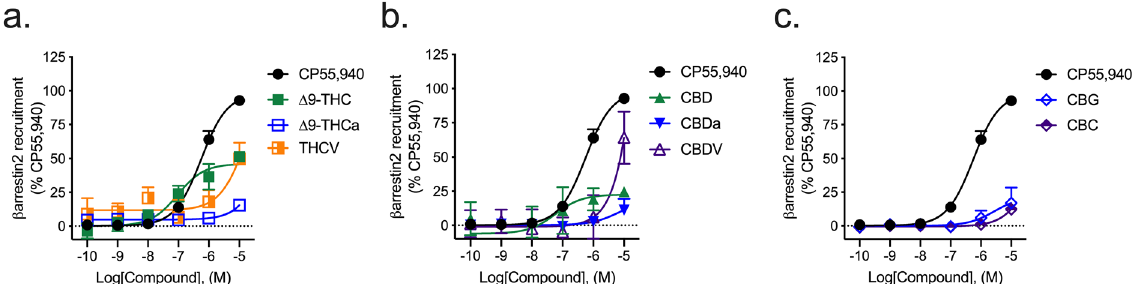
Figure 7. hCB2R-dependent recruitment of βarrestin2. hCB2R-dependent recruitment of βarrestin2 was quantified in PathHunter CHO cells stably expressing hCB2R and treated with 0.1 nM–10 µM ( a ) THC-like compounds; ( b ) CBD-like compounds; or ( c ) CBG, or CBC for 90 min. Data were fit to a variable slope (4 parameter) non-linear regression in GraphPad (v. 8). n ≥ 6 independent experiments performed in triplicate. E Max refers to the top of the concentration–response curve. Data are expressed as mean ± SEM. EC 50 and E max are reported in Table 3.